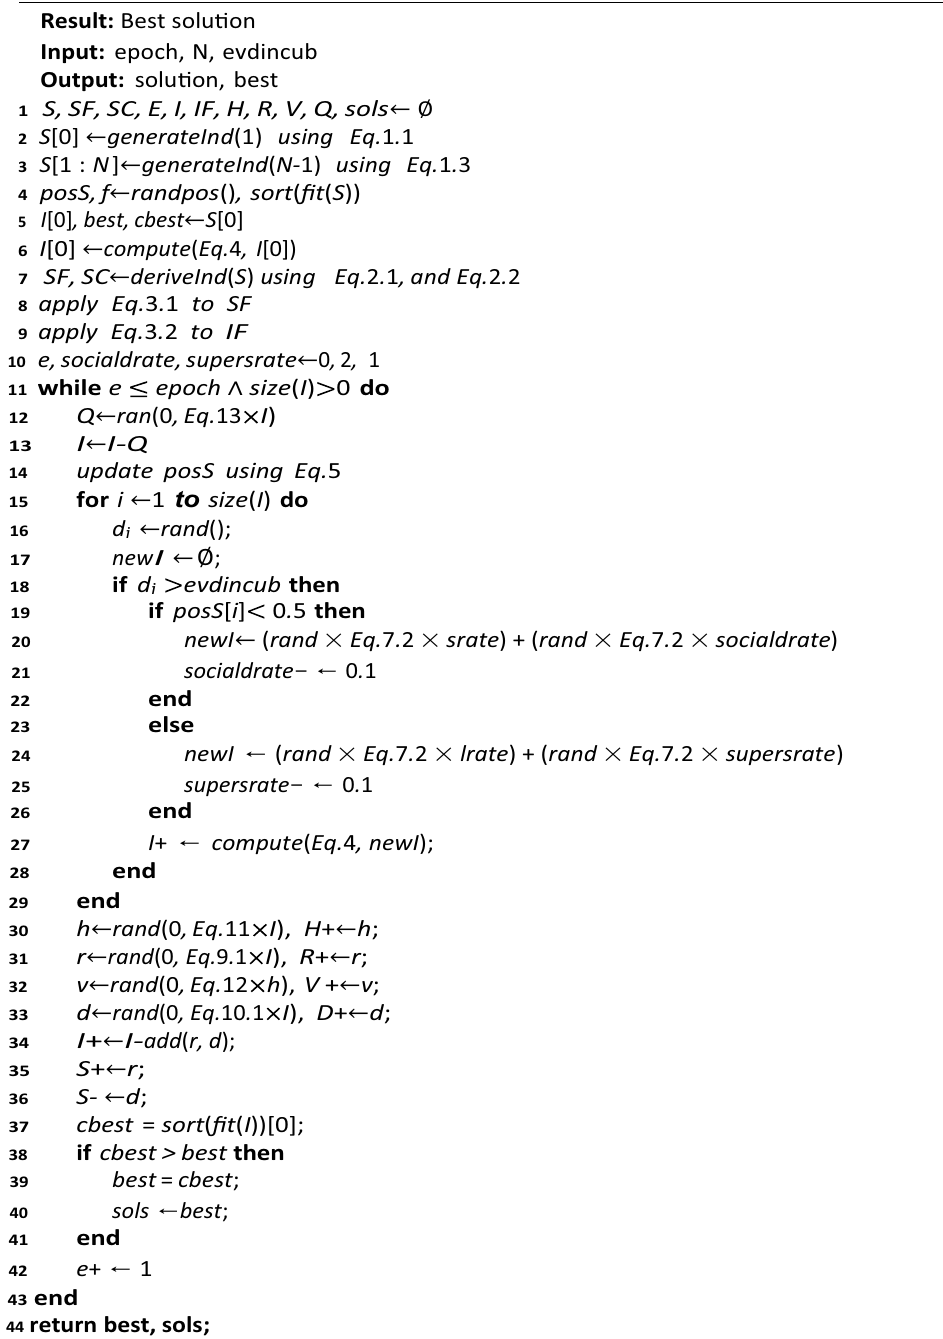
Algorithm 1: IEOSA metaheuris(cid:31)c algorithm pseudocode Result: Best